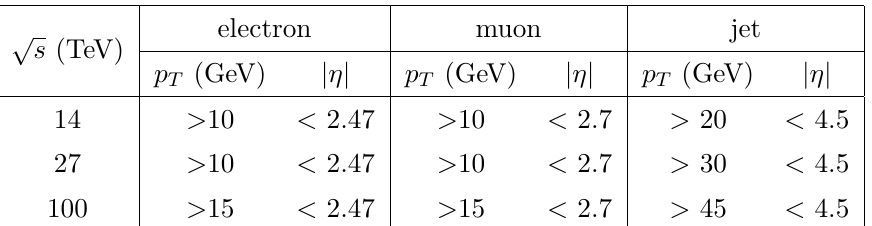
Table 1 . Geometrical acceptance cuts of electrons, muons and jets adopted in our data simulations √ at s = 14 TeV, 27 TeV and 100 TeV. In addition, for the leading lepton we take p ‘, leading